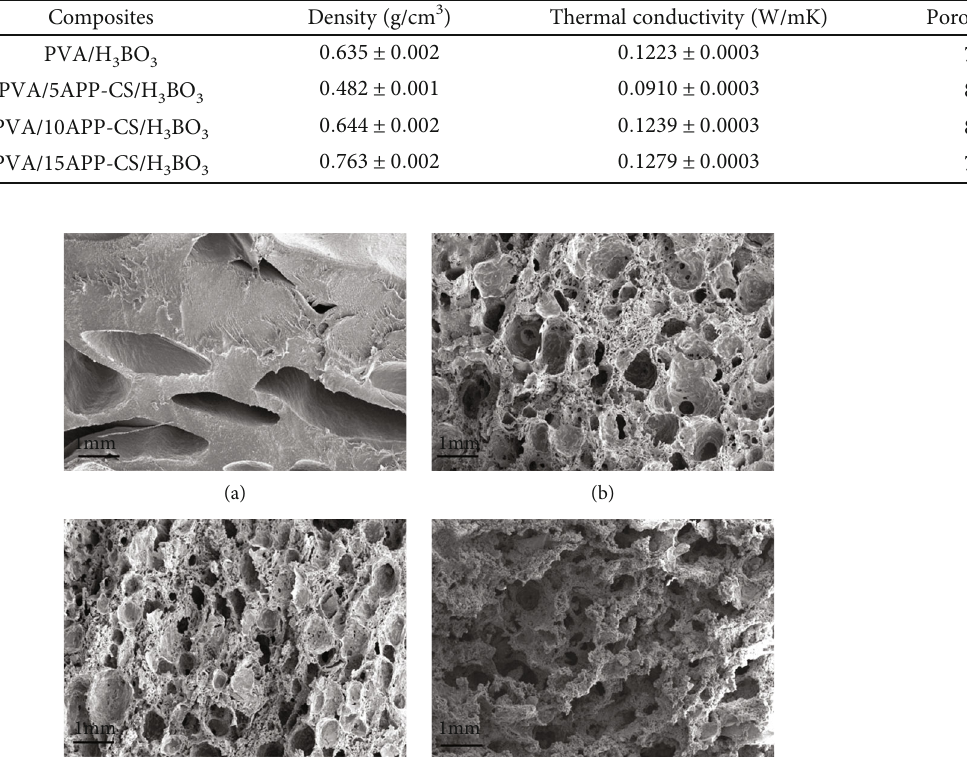
BO , (b) PVA/5APP-CS/H 3 3